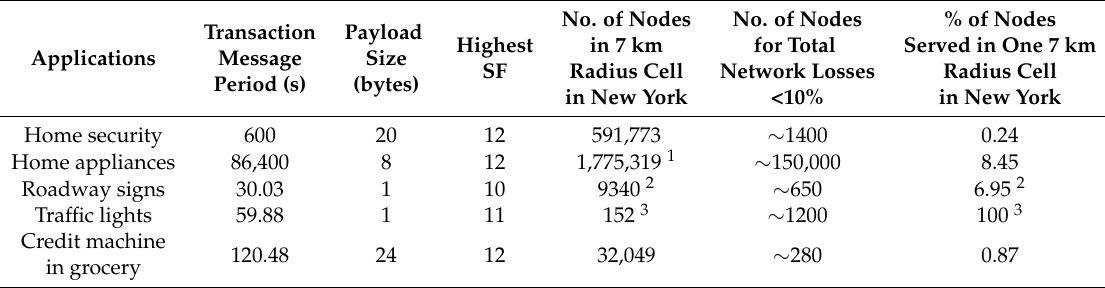
Table 8. LoRaWAN scalability for different IoT